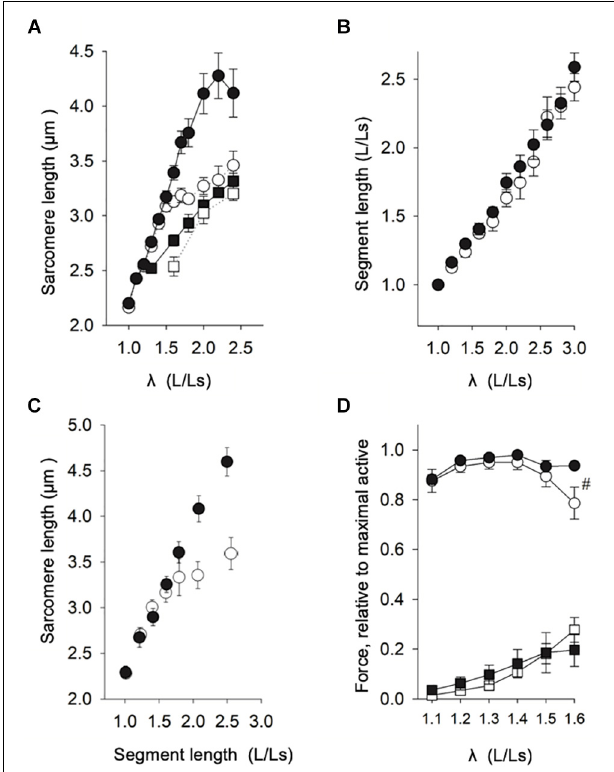
FIGURE 2 | Length-force analysis of woody and normal breast muscle. (A) Relation between muscle length (related to slack length, Ls) and sarcomere length in normal breast (open circles) and woody breast (filled circles) muscles (data from eight animals, 4–5 fibers each, grouped according to L/Ls, each L/Ls: n = 6–30). Filled squares show the relation of woody breast fibers compressed by 20% (to the same fiber diameter as that of normal breast fibers) using 4% dextran T-500, and open squares show the relation of normal breast fibers compressed by 20% using 4% dextran T-500. For L/Ls values ≥ 1.8, the sarcomere length of the woody breast group was significantly longer compared to normal muscle fibers ( P < 0.05, Two-way ANOVA). (B) Relation between segment length, i.e., the distance between two carbon dots adhered to the fiber surface (relative to slack length, Ls, ∼ 60 µ m), and muscle fiber length (relative to slack fiber length). (C) Relation between sarcomere length and segment length (relative to Ls) in normal (open circles) and woody (filled circles) muscle fibers (data from six animals, 2–3 fibers each, grouped according to segment length/Ls, n = 6–13). (D) Active (circles) and passive (squares) length-force relationships of normal (open symbols) and woody breast (filled symbols) fibers (average data from eight animals, 2–3 fibers each, grouped according to L/Ls, each L/Ls: n = 6–8). # Indicates significant difference in active force at L/Ls = 1.6 ( P < 0.05).